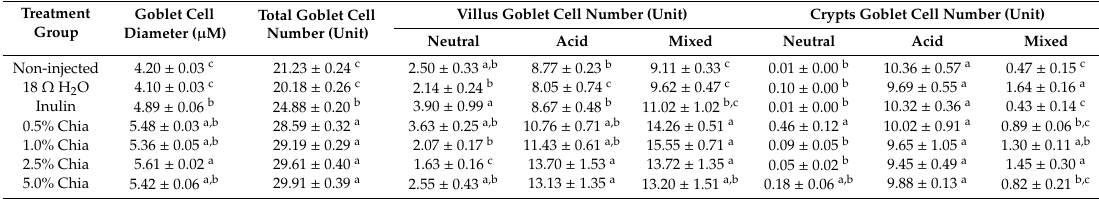
Table 8. E ff ect of the intra-amniotic administration of experimental solutions on the goblet cells. Treatment